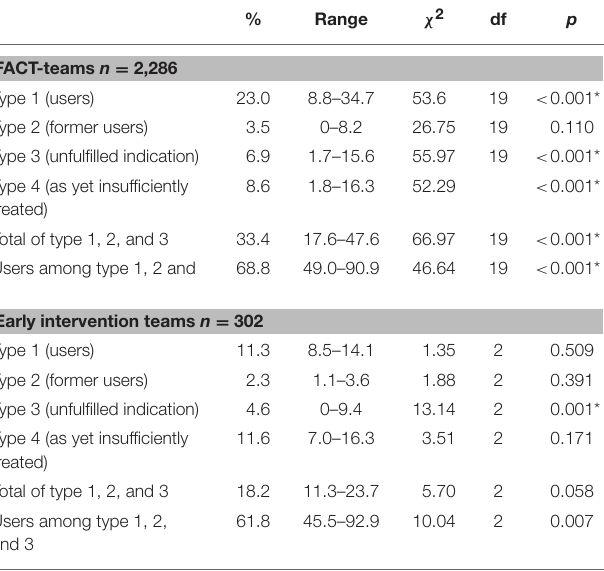
TABLE 2 | Mean proportion and range of type 1, type 2, type 3, and type 4 patients and results of χ 2 -tests to compare teams, in 20 Flexible Assertive Community Treatment (FACT)-teams and 3 Early intervention teams in the Netherlands,